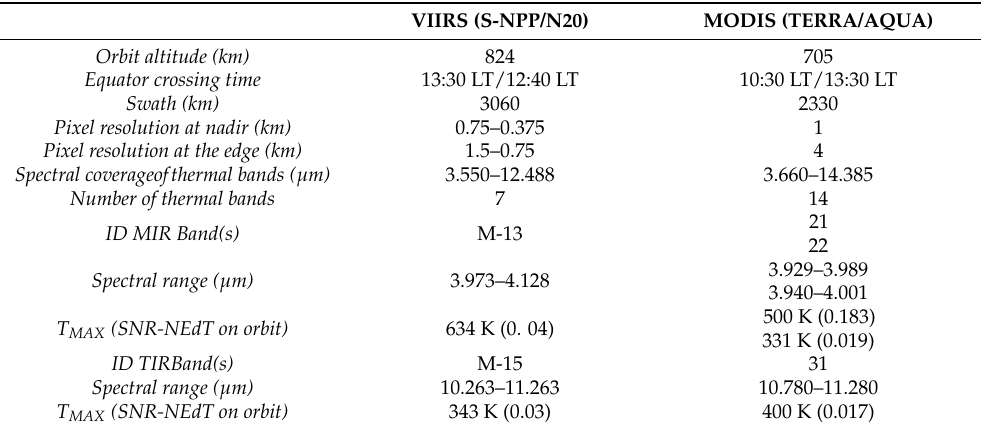
Table 1. Main characteristics and spectral bands of VIIRS and